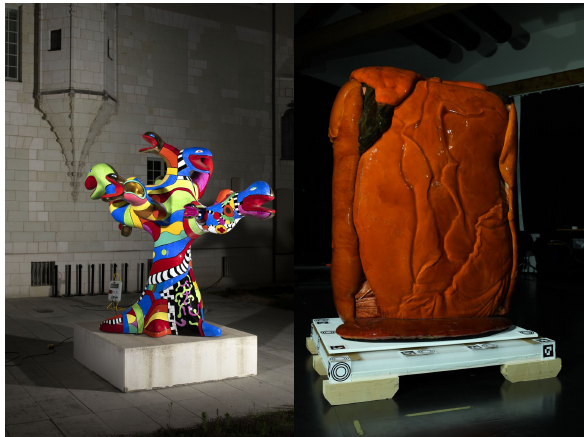
Figure 1 and 2 . Photography of “L’Arbre aux serpents” by Niki de Saint-Phalle (left) and “Expansion contrôlée” by César (right)